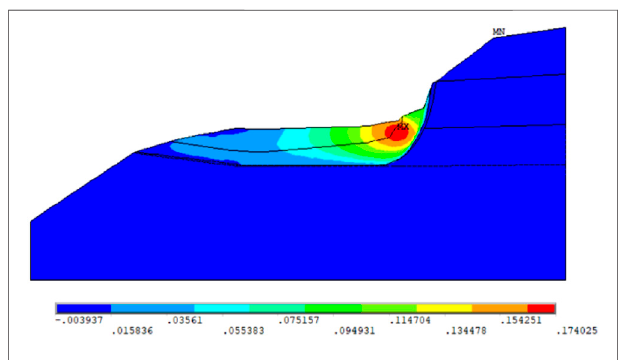
FIGURE 8 | Displacement value diagram of sliding body in deep sliding surface of Xiashan